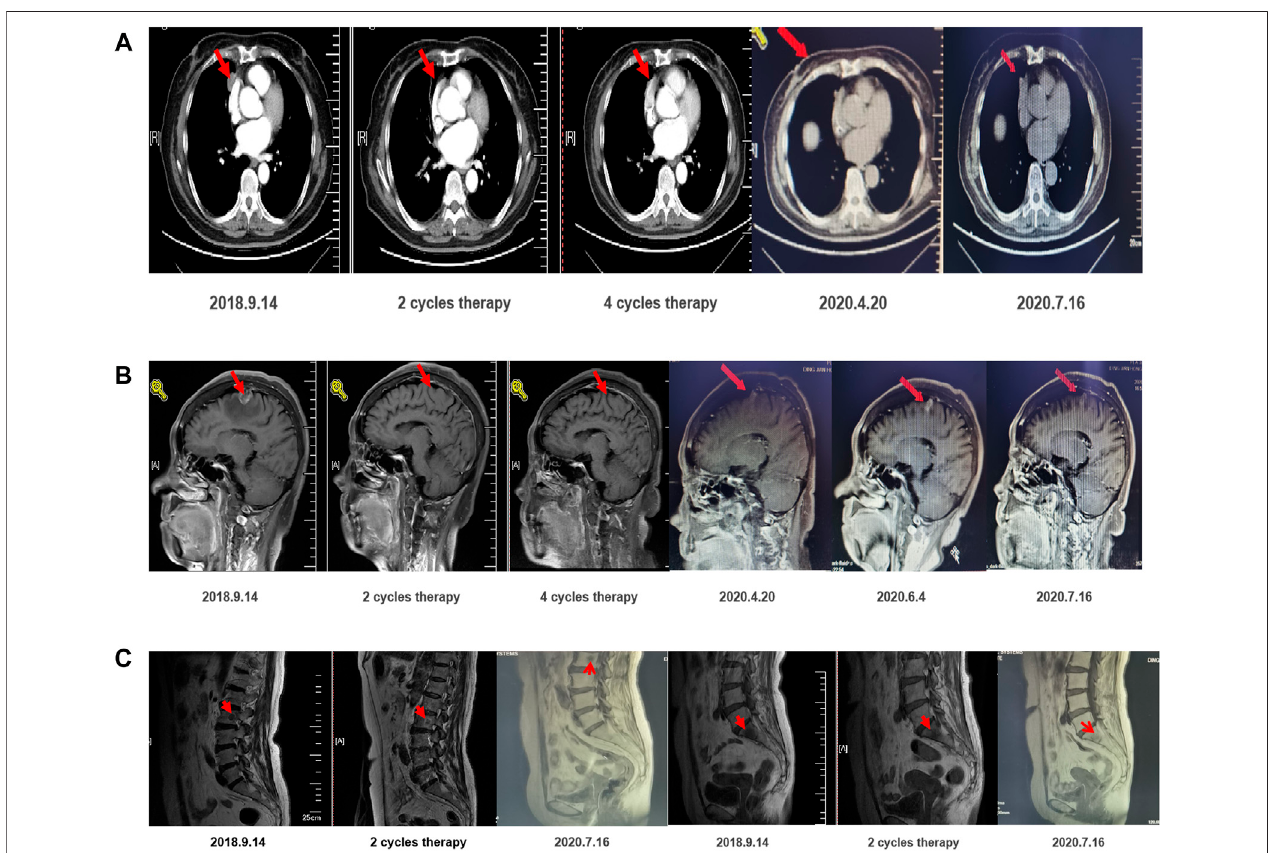
FIGURE 1 | Imaging regression of the lesion demonstrates the effectiveness of the treatment regimen.